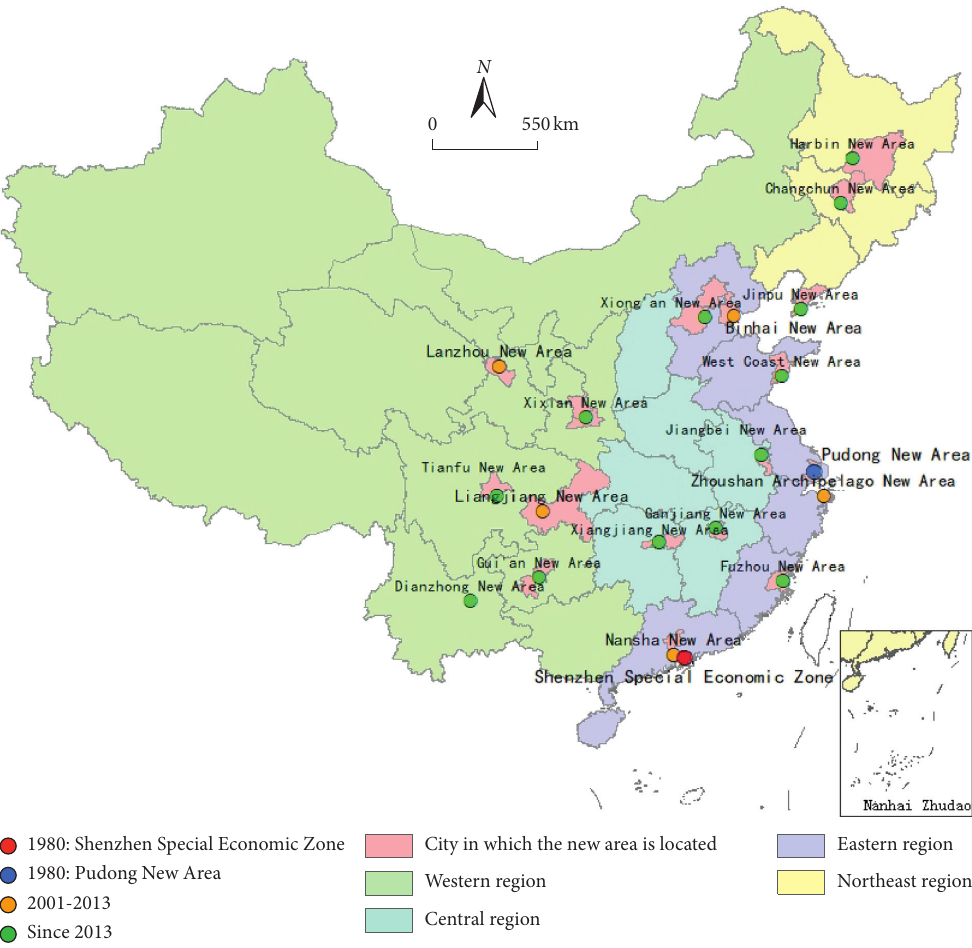
Figure 1: Spatiotemporal distribution of China’s new